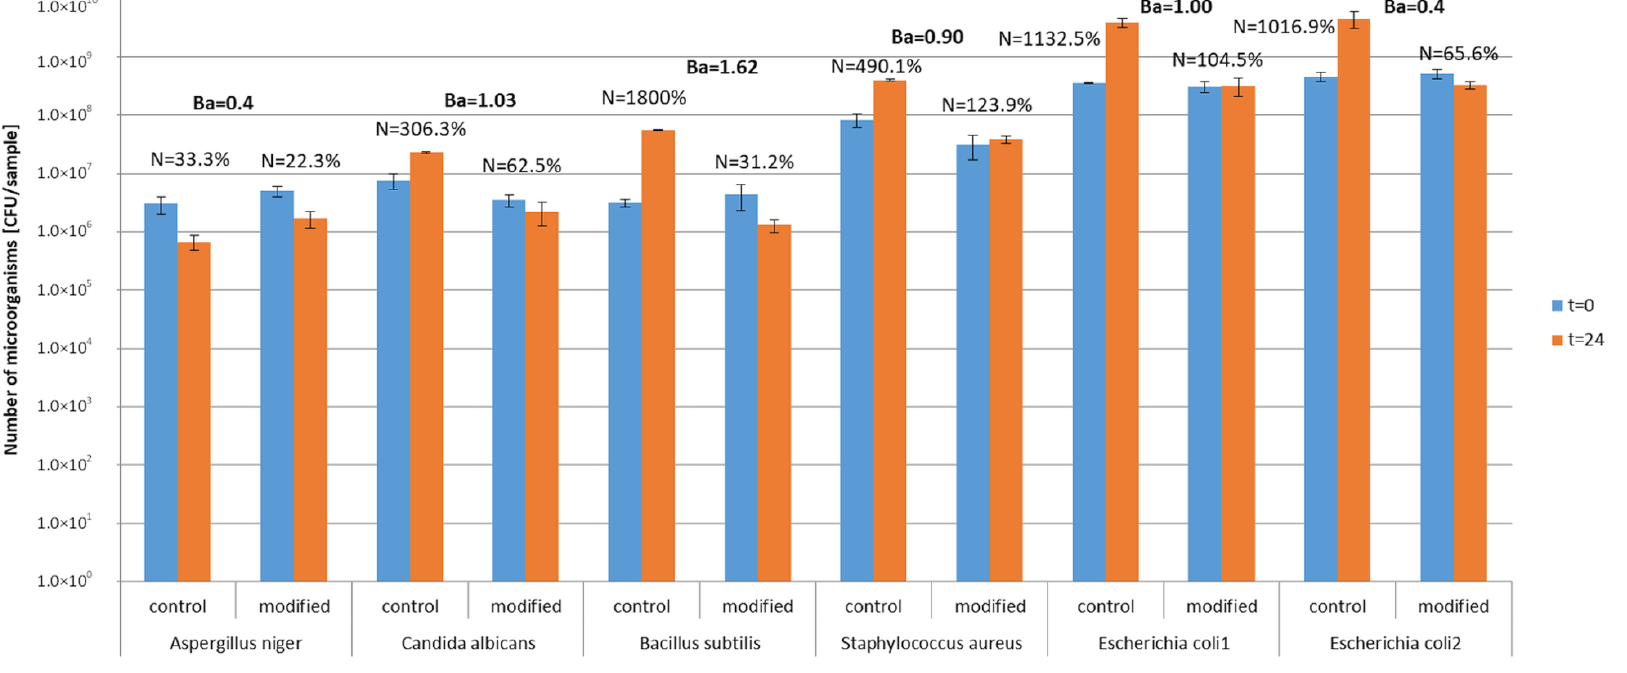
Figure 6. Antimicrobial activity of textiles—study in model conditions. N—survival index; Ba—biostatic activity; 1 sample incubated without lighting, 2 sample incubated with natural lighting.